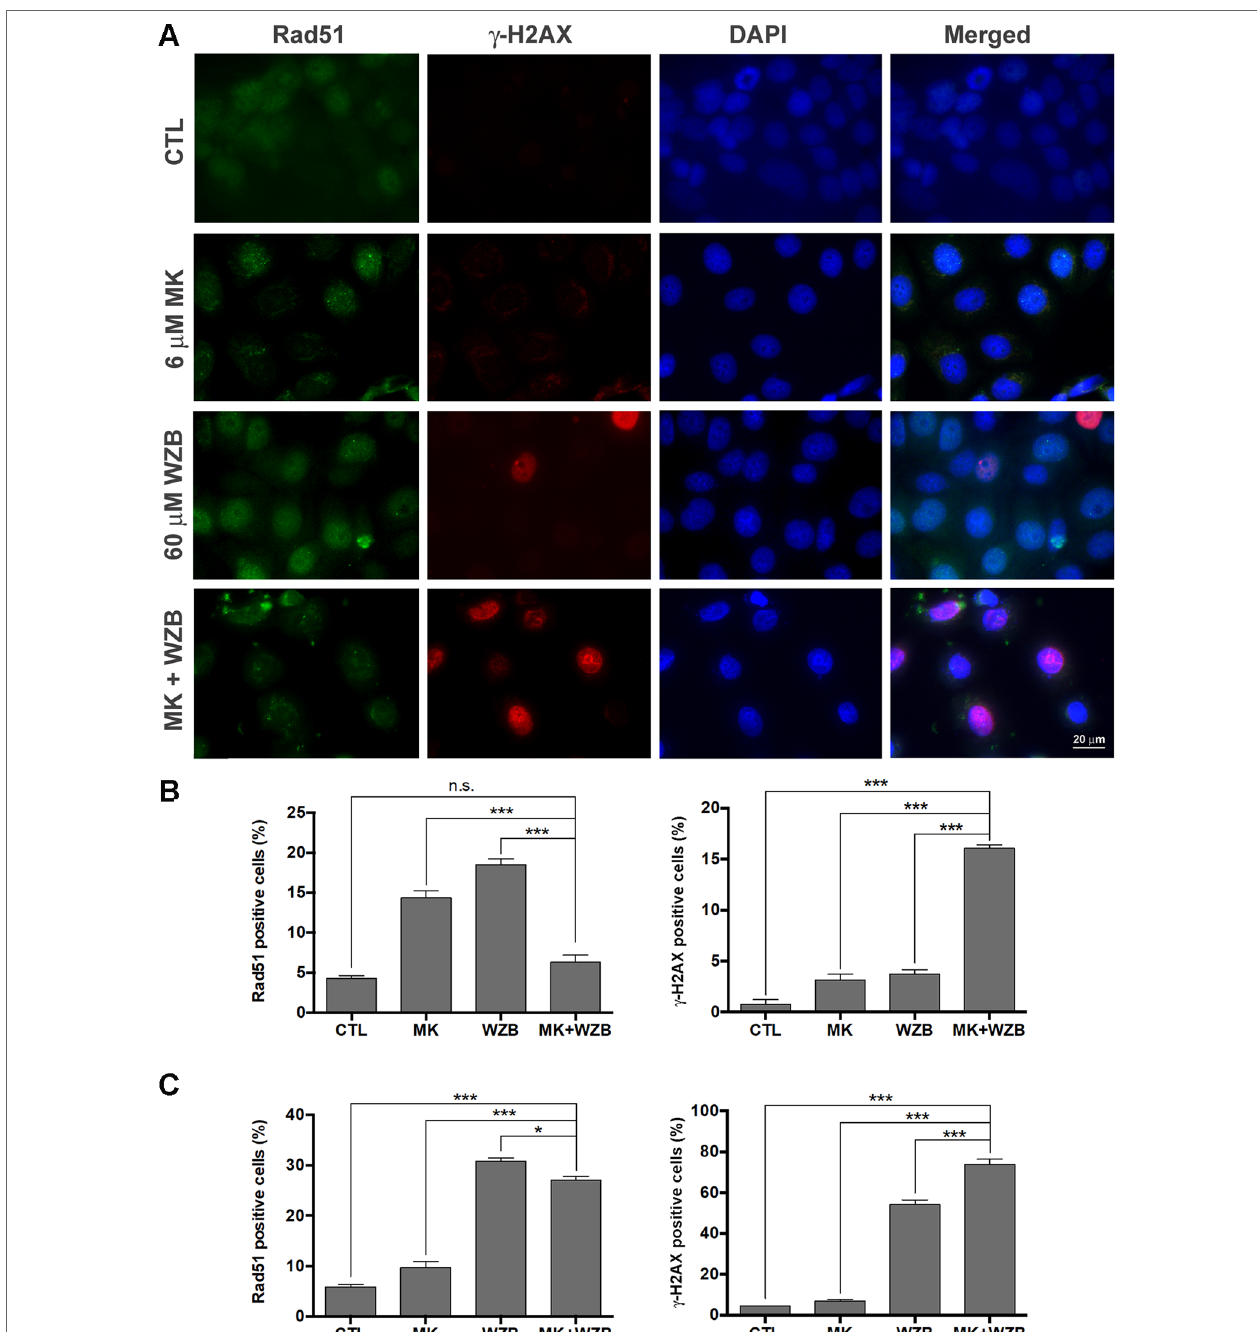
FIGURE 6 | MK-2206 and WZB117 induce DNA damage and may compromise DNA repair. (A) Images of MCF-7 cells stained with Rad51 ( green ) and γ-H2AX ( red ) 24 h after drug treatment. The nucleus was counterstained with DAPI ( blue ). Scale bar , 20 μm. (B) Quantitative data of Rad51-positive and γ-H2AX-positive MCF-7 cells. (C) Quantitative data of Rad51-positive and γ-H2AX-positive MDA-MB-231 cells. MCF-7 cells were treated with 6 μM MK-2206 and/or 60 μM WZB117 and MDA-MB-231 cells were treated with 12 μM MK-2206 and/or 60 μM WZB117 for 24 h. Rad51-positive cells were defined as those with five or more Rad51 nuclear foci. Data are presented as the mean ± SEM of three independent experiments. * P < 0.05; *** P < 0.001; n.s., not significant (P >